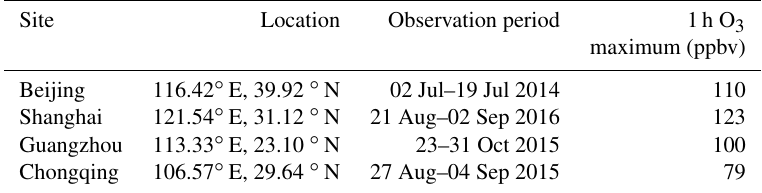
Table 1. Overview of the measurement